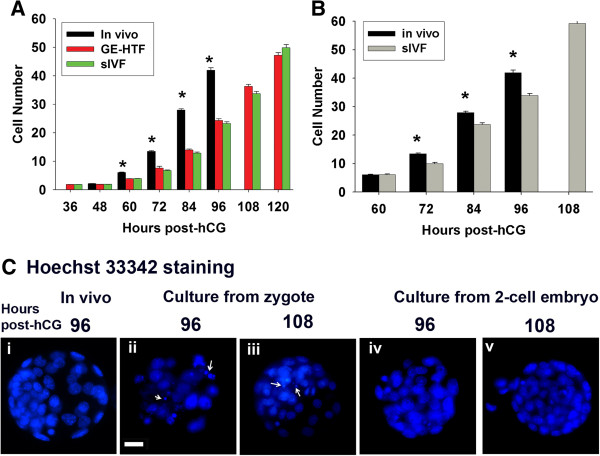
The effects of embryo culture on developmental viability. (A) Hybrid strain (B6CBF1) zygotes collected 20 h post-hCG or (B) 2-cell embryos 44 h post-hCG were cultured as 10 embryos in a drop of 10 μL GE-HTF medium or sIVF media under 5% CO2 in air (20% O2). The cell number of the cultured embryos and the embryos freshly collected from reproductive tracts at a 12 h interval from (A) 36 h post-hCG or (B) 60 h was recorded. Each time point is the record of least 80 embryos from 3 independent replicates. *p < 0.001, compared to the corresponding stage of cultured embryo. (C) Representative images of embryos stained with Hoechst 33342 and examples of fragmented nuclei shown with arrows.